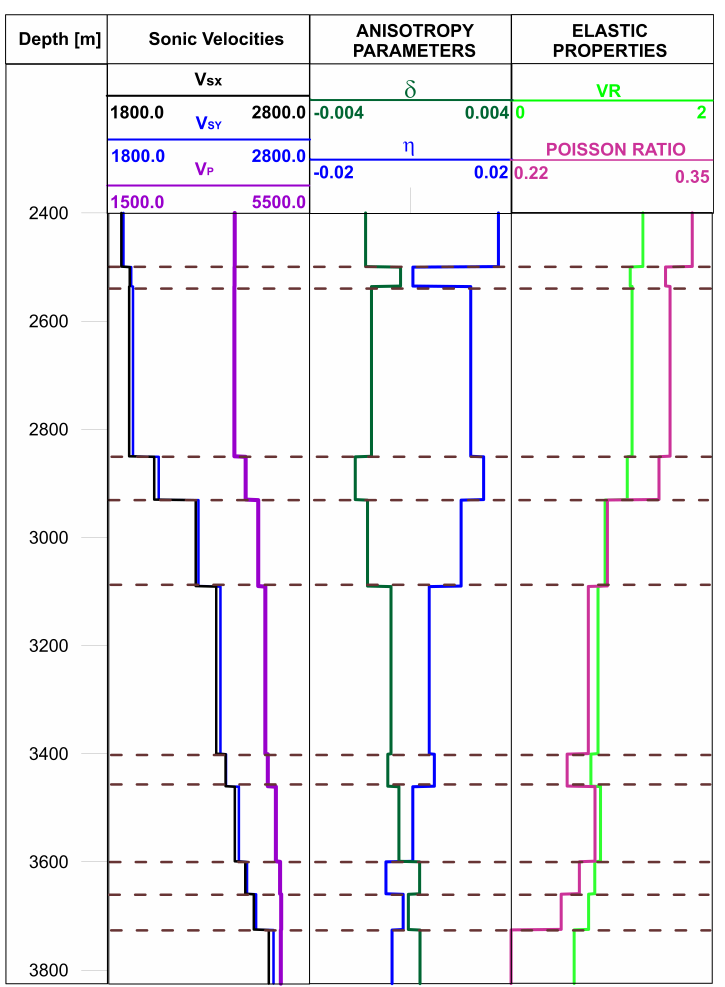
Figure 18. Comparison of averaged lithological layer values of sonic V SX , V SY , and V P velocities ( the first block ); δ and η from VSP inversion ( the second block ); and V r with Poisson ratio ( the third block